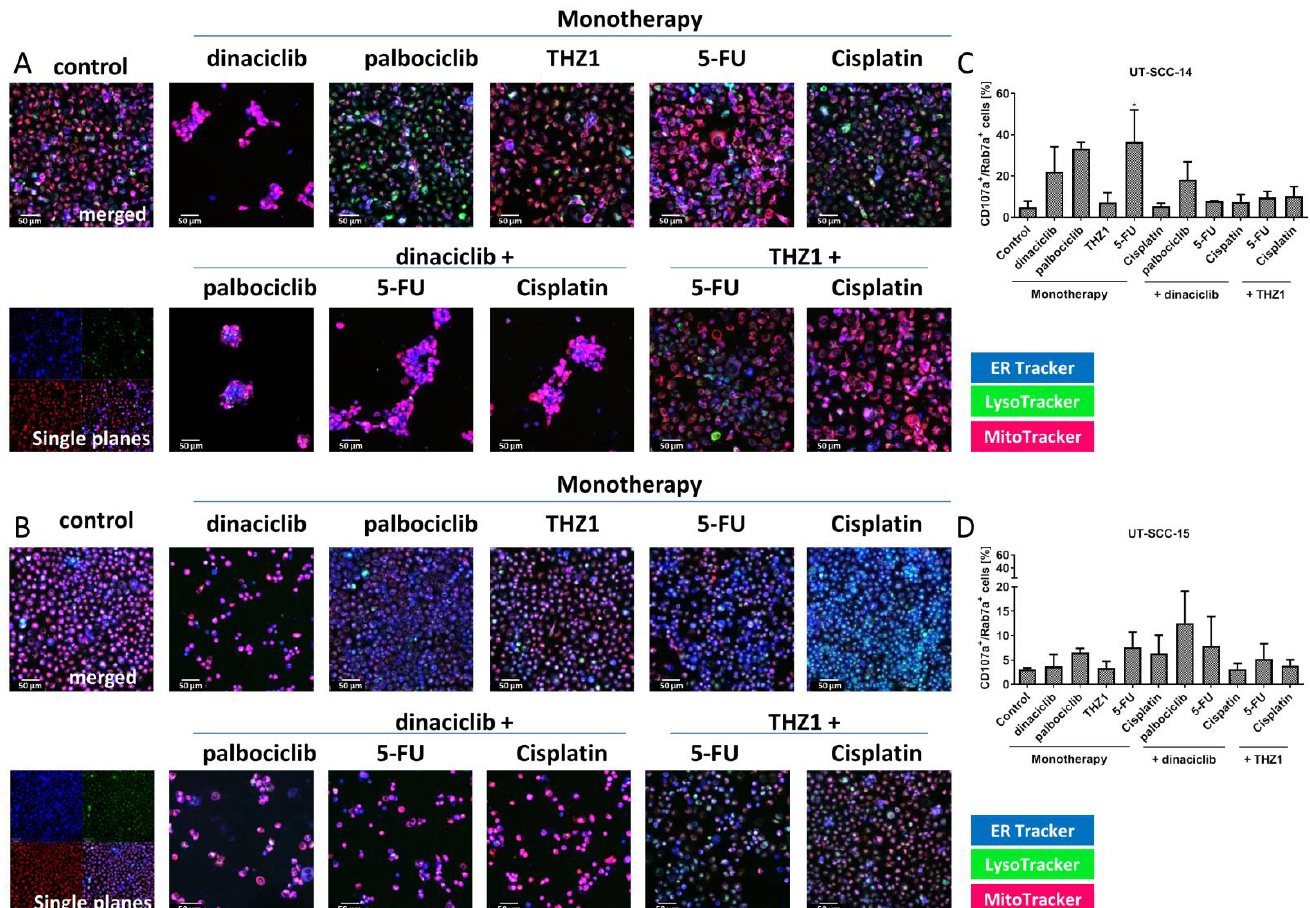
Figure 6. Influence on mitochondria, lysosomes, ER, and vacuole formation ( A , C ) UT-SCC-14 and ( B , D ) UT-SCC-15 cells. ( A , C ) To investigate the effect of the test substances on the mitochondrial activity, the lysosome formation, and the ER, cells were treated for 72 h with test substances and stained with MitoTracker (red), LysoTracker (green), and ER-Tracker (blue). Drug doses were as follows: dinaciclib [0.02 µM]; palbociclib [1 µM]; THZ1 [UT-SCC14: 0.02 µM; UT-SCC-15: 0.005 µM]; 5-FU [90 µg/mL]; Cisplatin [0.1 µg/mL]. Representative merged images are shown. For the control, a separated fluorescent image is shown. Analysis was performed with a ZEISS Elyra 7 Confocal Laser Microscope. ( C , D ) Cells were stained for CD107a and Rab7a as a hint for vacuole formation and measured via flow cytometry. The percentage numbers of double positive cells are shown. Drug doses were as follows: dinaciclib [0.02 µM]; palbociclib [1 µM]; THZ1 [UT-SCC14: 0.02 µM; UT-SCC-15: 0.005 µM]; 5-FU [90 µg/mL]; Cisplatin [0.1 µg/mL]. 1way ANOVA ( n = 3 independent experiments) * p < 0.05 vs. control.